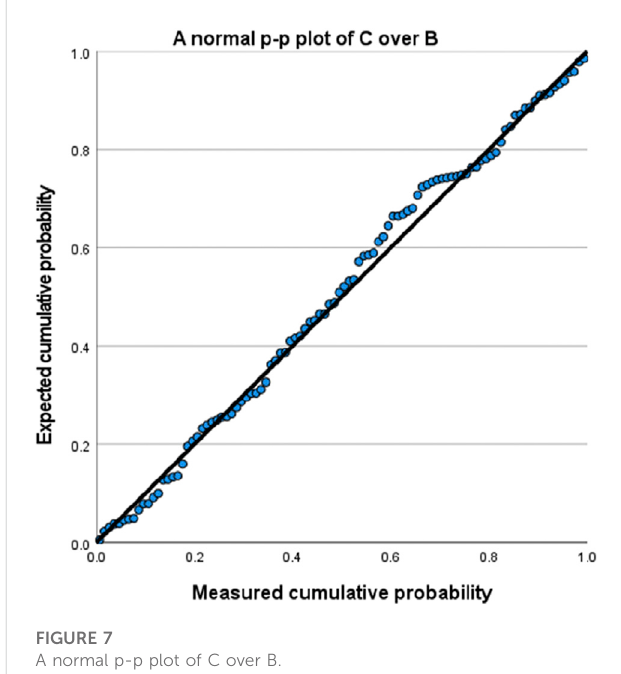
FIGURE 7 A normal p-p plot of C over